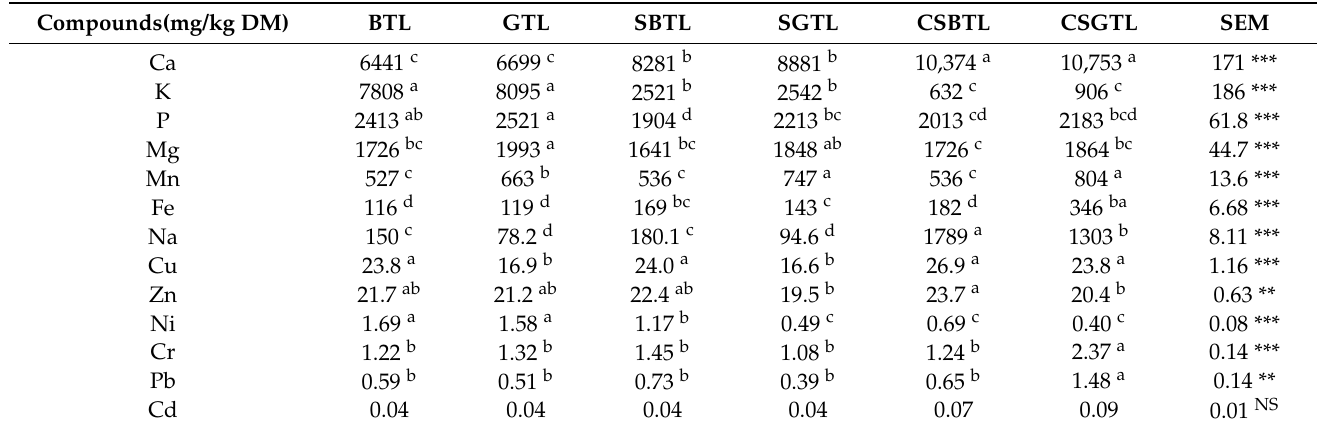
Table 3. Mean ( n = 3) mineral components (mg/kg DM) of different tea leaf products with SEM and